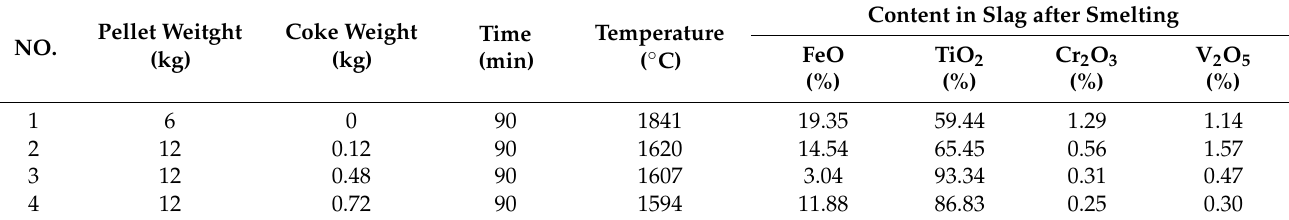
Table 8. Composition of coke samples (wt.%).